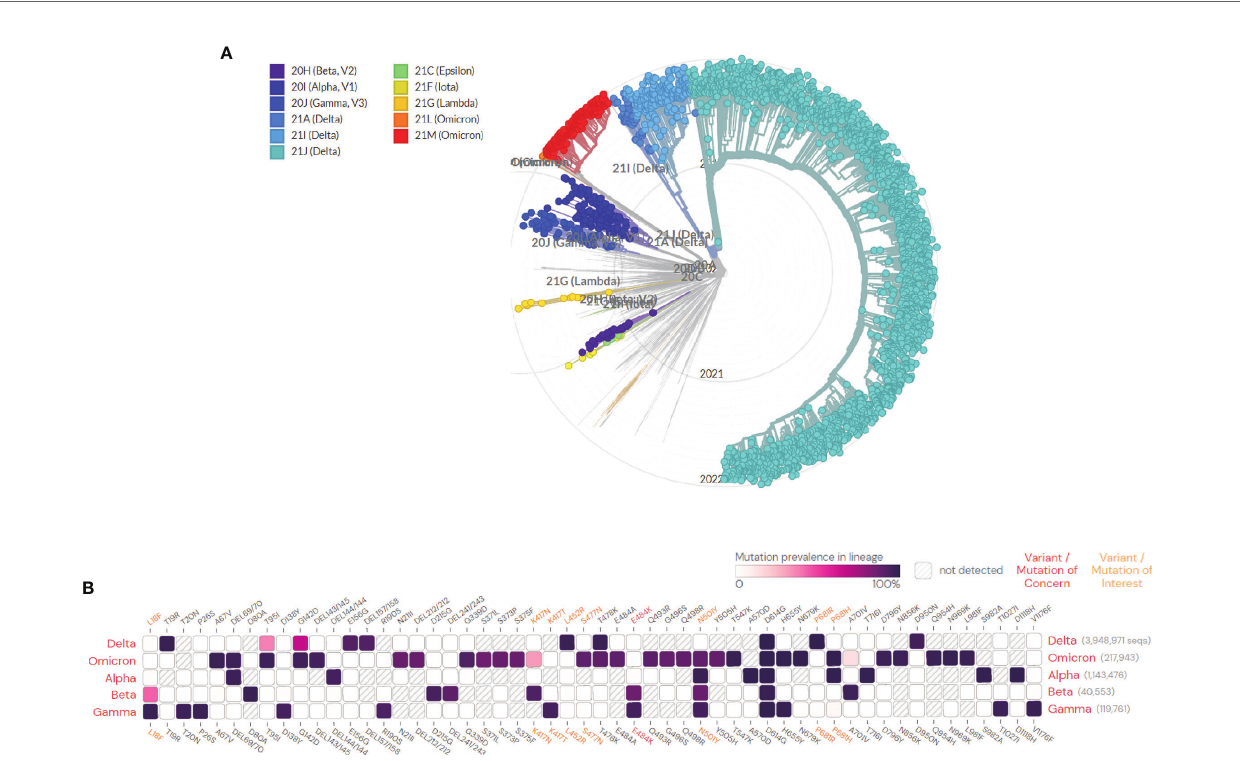
FIGURE 2 | (A) SARS-CoV-2 global phylogeny reveals the Omicron lineage. The Nextstrain platform provides a time-calibrated worldwide SARS-CoV-2 phylogeny (https://nextstrain.org/ncov/gisaid/global). Red and orange indicate the current status of the highly observed Omicron variant, and the variants of concern (VOCs) (Alpha, Beta, Gamma, Delta, and Omicron) and variants of interest (VOIs) (Lambda, Lota, and Epsilon) are colored as indicated. These variants are all described in detail in the article. (B) Mutation prevalence across lineages. The Outbreak platform provides S protein mutation prevalence across lineages. (Mutations with > 75% prevalence in at least one lineage) (https://outbreak.info). The fi gure describes in detail the mutation prevalence in lineage of VOCs. Orange indicates a mutation of interest and the red indicates a mutation of concern. Blank indicates that the mutation has not detected. White to purple indicates the prevalence of the mutation in all